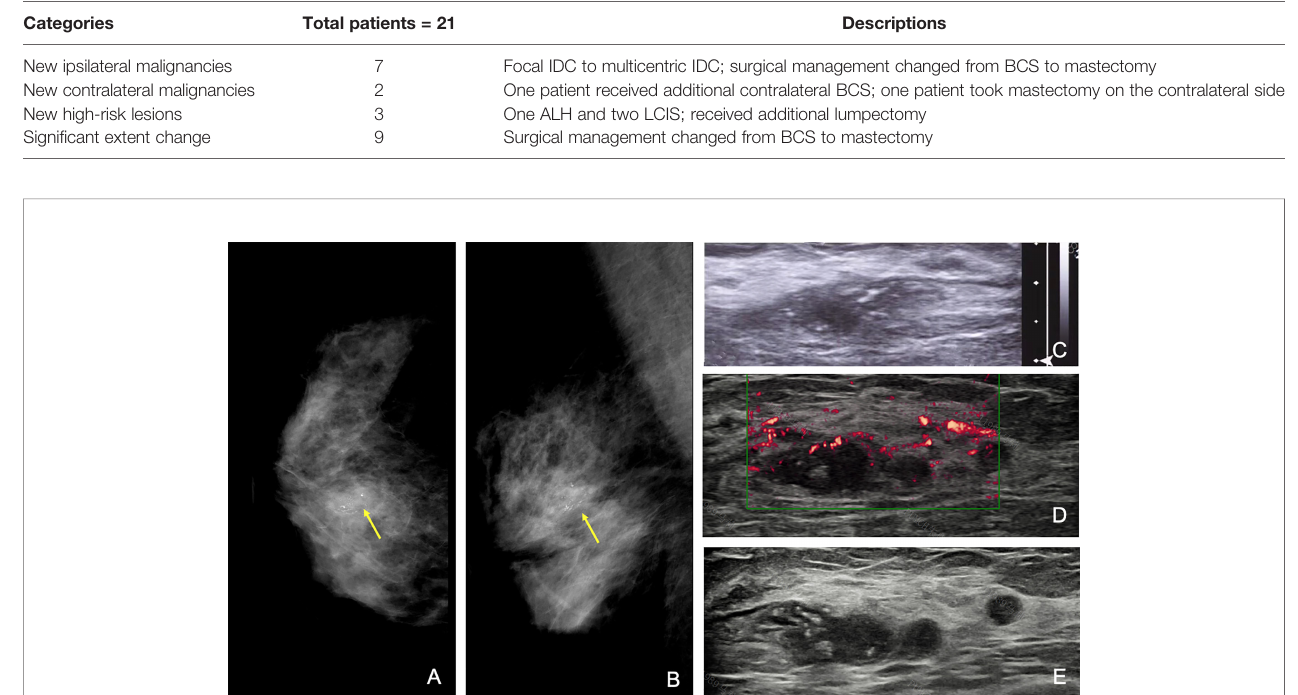
FIGURE 4 | A 58-year-old woman with a category 4c mass with grouped fi ne branched calci fi cation at 1 o ’ clock of the right breast, with the largest diameter of 1.5 cm at the initial assessment. Craniocaudal (A) and mediolateral oblique (B) mammograms of the right breast and initial US (C) of the right mass (arrow). The initial largest diameter was assessed as 1.8 cm. (D) Second US showing an irregular hypoechoic mass with multiple satellite nodules (arrows), and the largest diameter was 4.3 cm. The patient fi nally received mastectomy of the right breast, and pathological results were in fi ltrative ductal carcinoma and ductal carcinoma in situ , with a total range of approximately 4.0 cm. Note that the time interval between the fi rst and second US studies was 2